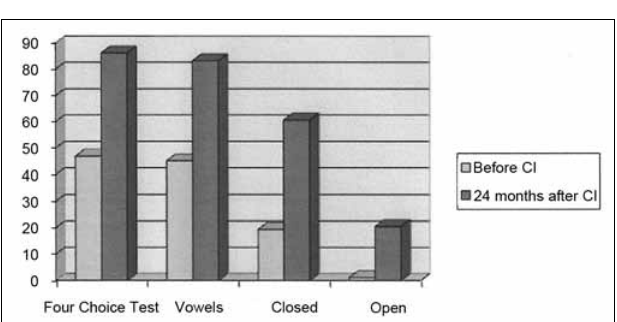
Figure 1. Mean value of the percentage of correct answers for the four choice , vowels, closed and open sentences before and 24 months after the cochlear